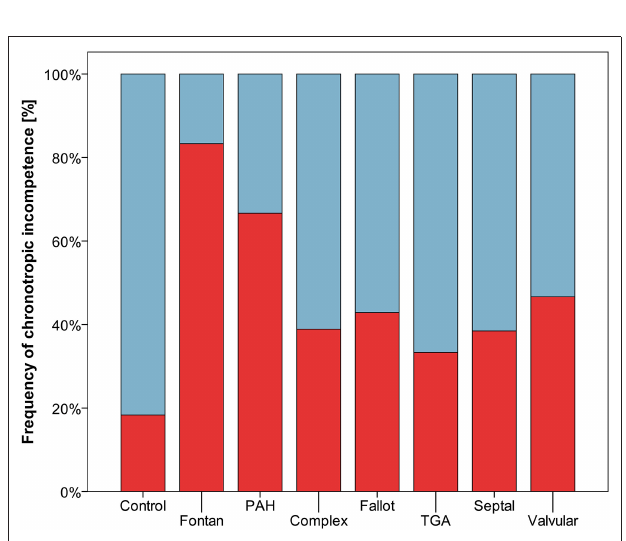
FIGURE 2 | Frequency of chronotropic incompetence (threshold defined as chronotropic index < 0.8) marked red.